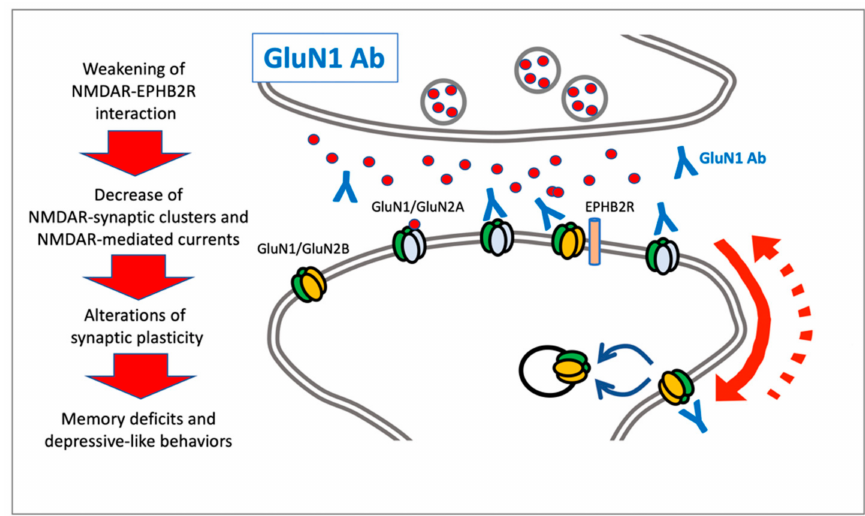
Figure 1. Graphic representation of molecular and cellular mechanisms triggered by anti-GluN1 antibodies through interaction with synaptic or extrasynaptic